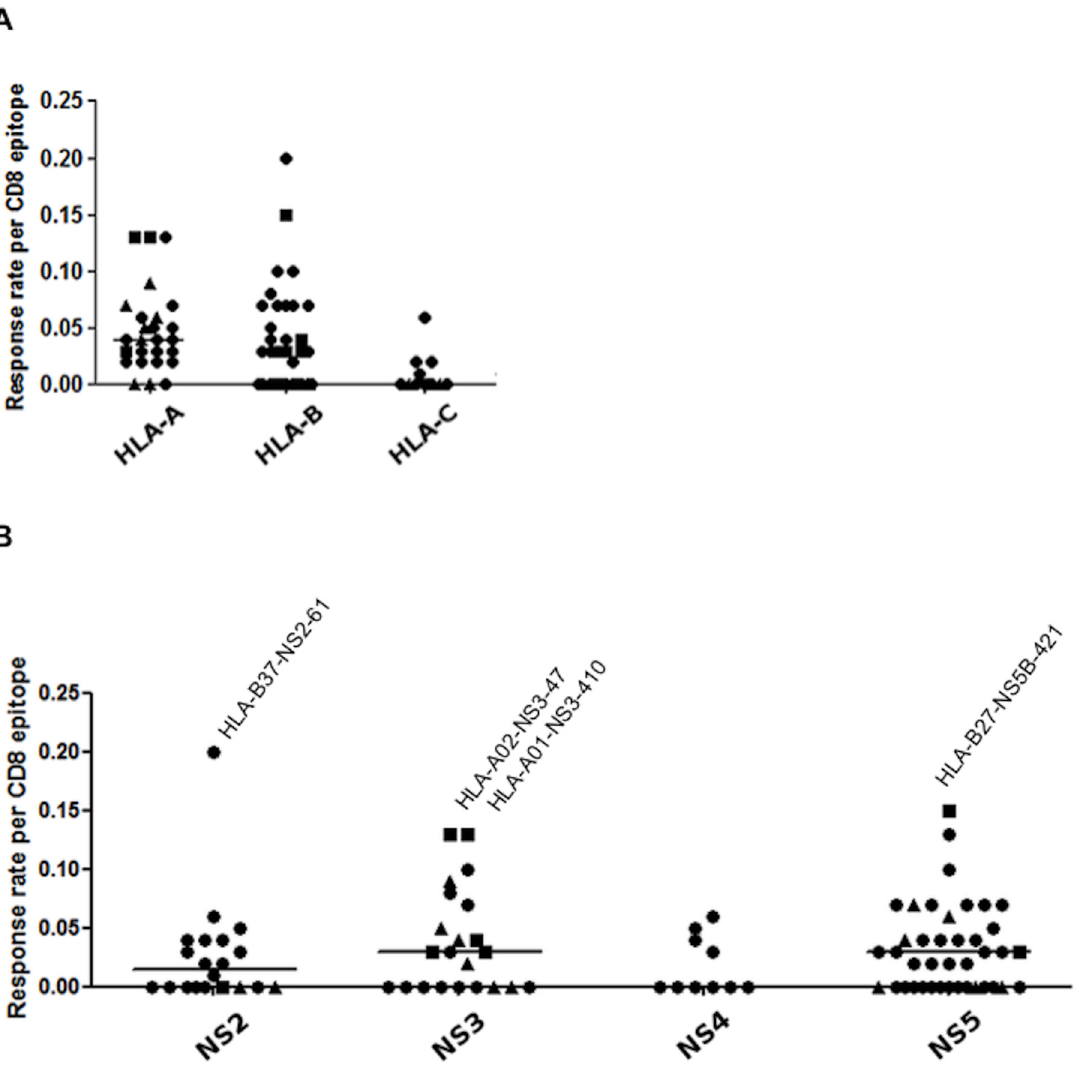
Fig 2. A. Contribution of HLA-A-, -B- and -C-restricted responses to overall anti-HCV immunity in the cohort. Response rates of predicted (circle), published with adaptation (square) and published (triangle) HCV CD8 + T-cell epitopes are shown in relation to the HLA loci. HLA-A-restricted T-cell epitopes have a significantly higher response rate compared to HLA-B- and -C-restricted T-cell epitopes (p = 0.008 and p = 0.0007, respectively). B. Response rate of T-cell epitopes within the HCV non-structural proteins. Predicted (circle) T-cell epitope, published T-cell epitope with adaptation (square) and published (triangle) T- cell epitopes that elicit an IFN- γ response. T-cell epitopes with the highest response rates are indicated. There was a greater response rate in NS3 relative to the other proteins (p =